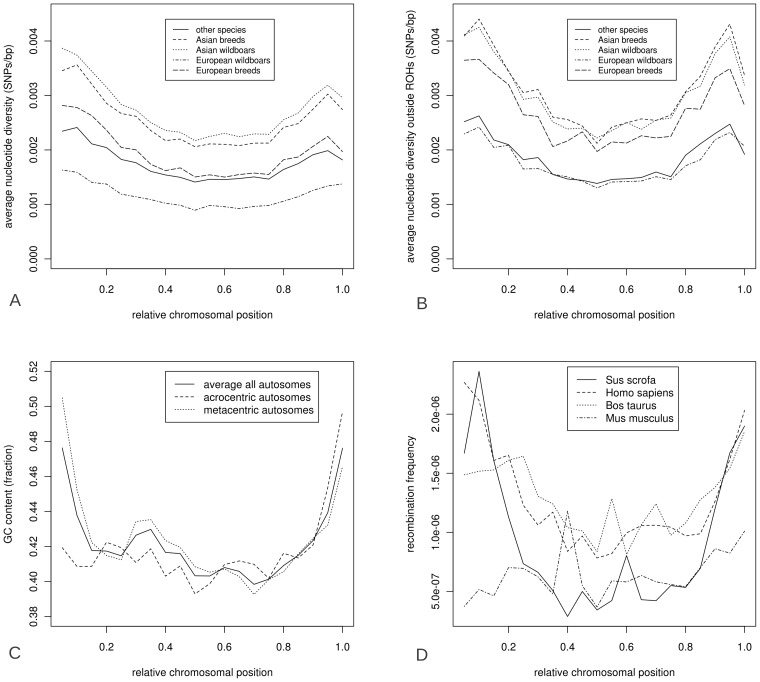
Characteristics of the porcine genome over relative chromosomal position.Physical distribution of total nucleotide diversity (6A), nucleotide diversity outside ROHs (6B), GC content (6C), recombination rate (6D) over chromosomes. Relative chromosomal position is averaged for all chromosomes so that 0.0 represents the left telomeric region and 1.0 the far right telomere.